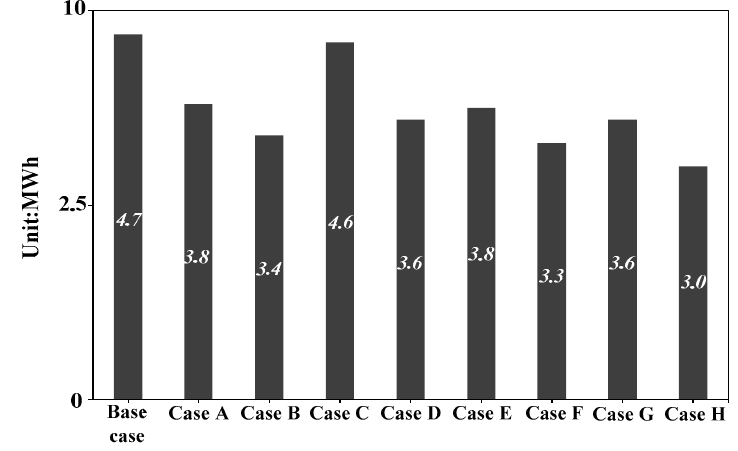
Figure 9. Comparison of annual cooling loads with the combinations of design alternatives.